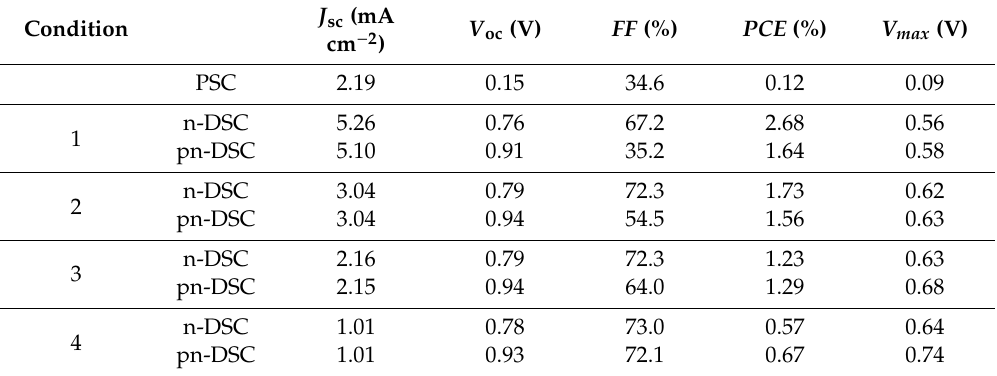
Table 1. Photovoltaic parameters of the calculated pn-DSCs as well as p-DSCs and n-DSCs. J sc (mA Condition cm − 2